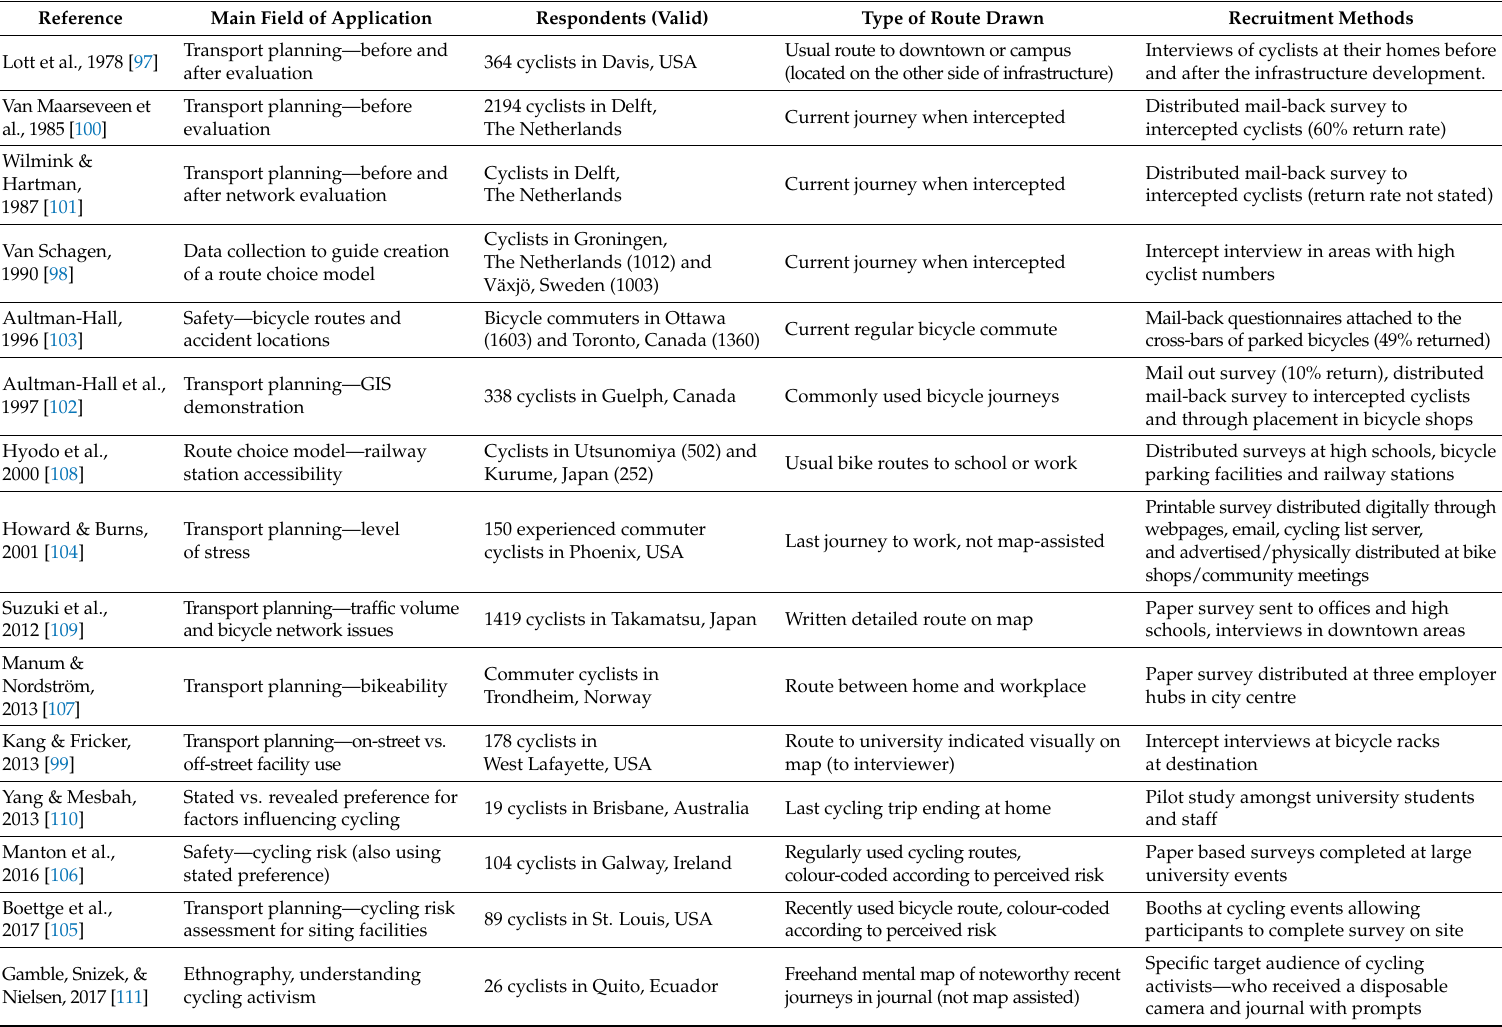
Table A2. Hand-drawn route recall